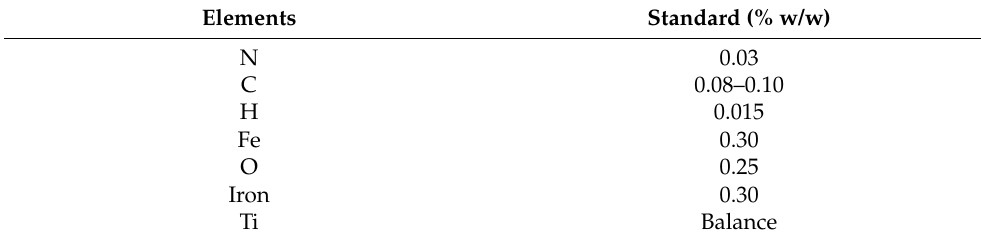
Table 1. The chemical composition of the titanium alloy grade 2.